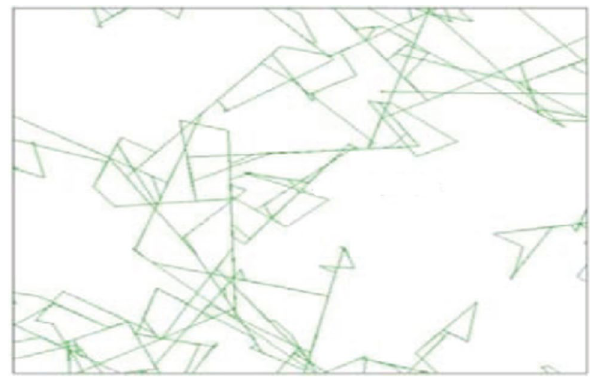
Fig. 9 Status and location of natural fractures around the well